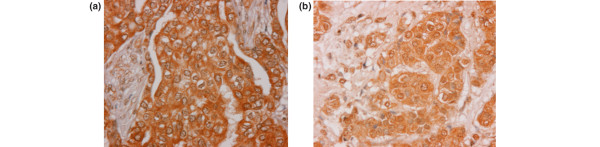
Photomicrographs of immunohistochemical staining using (a) H4.77.16 and (b) HFR1 antibodies.